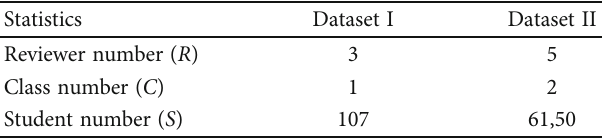
Table 1: Statistics for the two